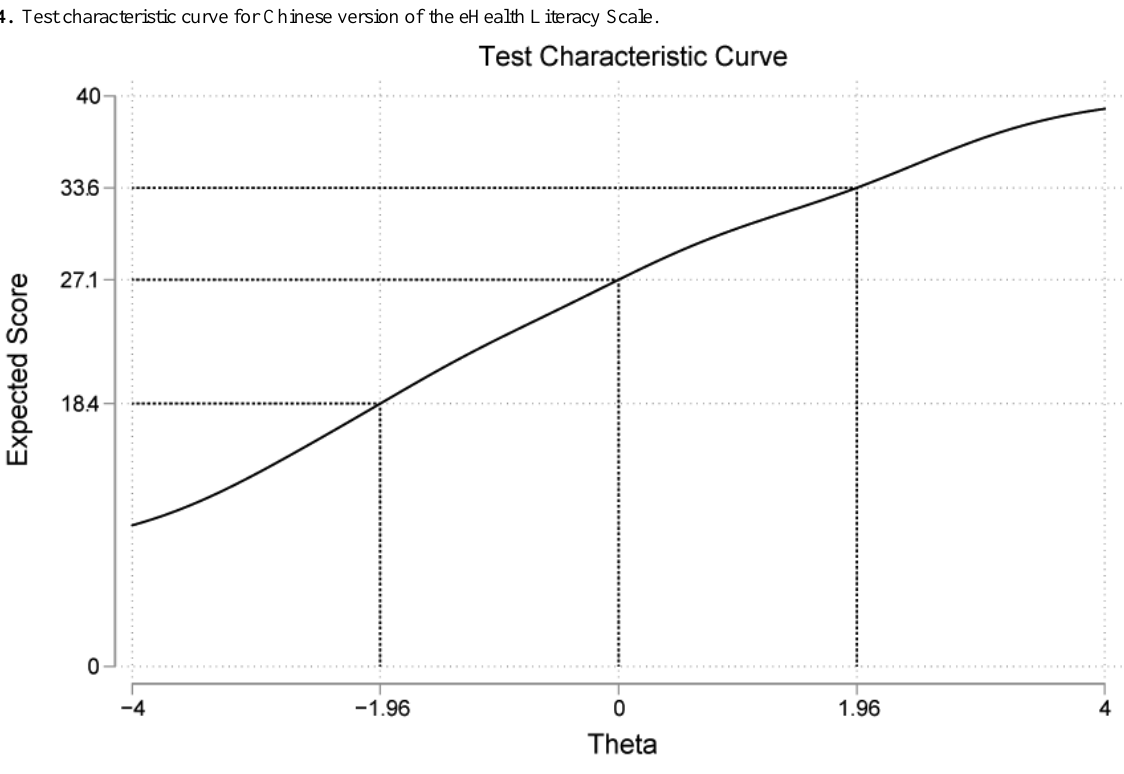
Figure 4. Test characteristic curve for Chinese version of the eHealth Literacy